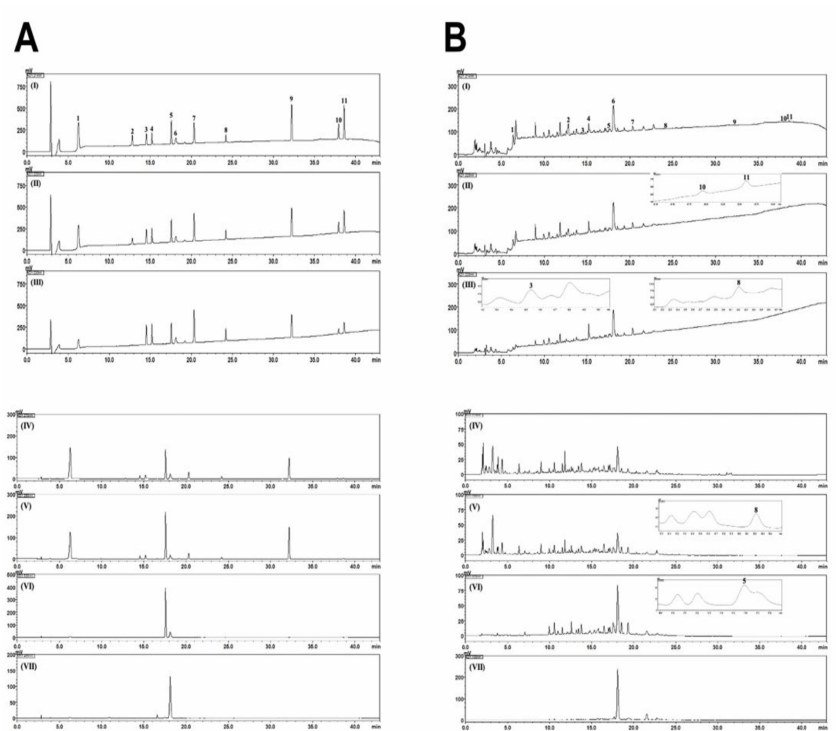
Figure 1. HPLC chromatograms of the standard mixture ( A ) and THD sample ( B ) at UV detection wavelengths of 214 nm ( I ), 220 nm ( II ), 230 nm ( III ), 270 nm ( IV ), 280 nm ( V ), 320 nm ( VI ), and 400 nm ( VII ). Gallic acid (1), amygdalin (2), albiflorin (3), paeoniflorin (4), ferulic acid (5), safflomin A (6), benzoic acid (7), benzoylpaeoniflorin (8), 6-gingerol (9), costunolide (10), and dehydrocostus lactone